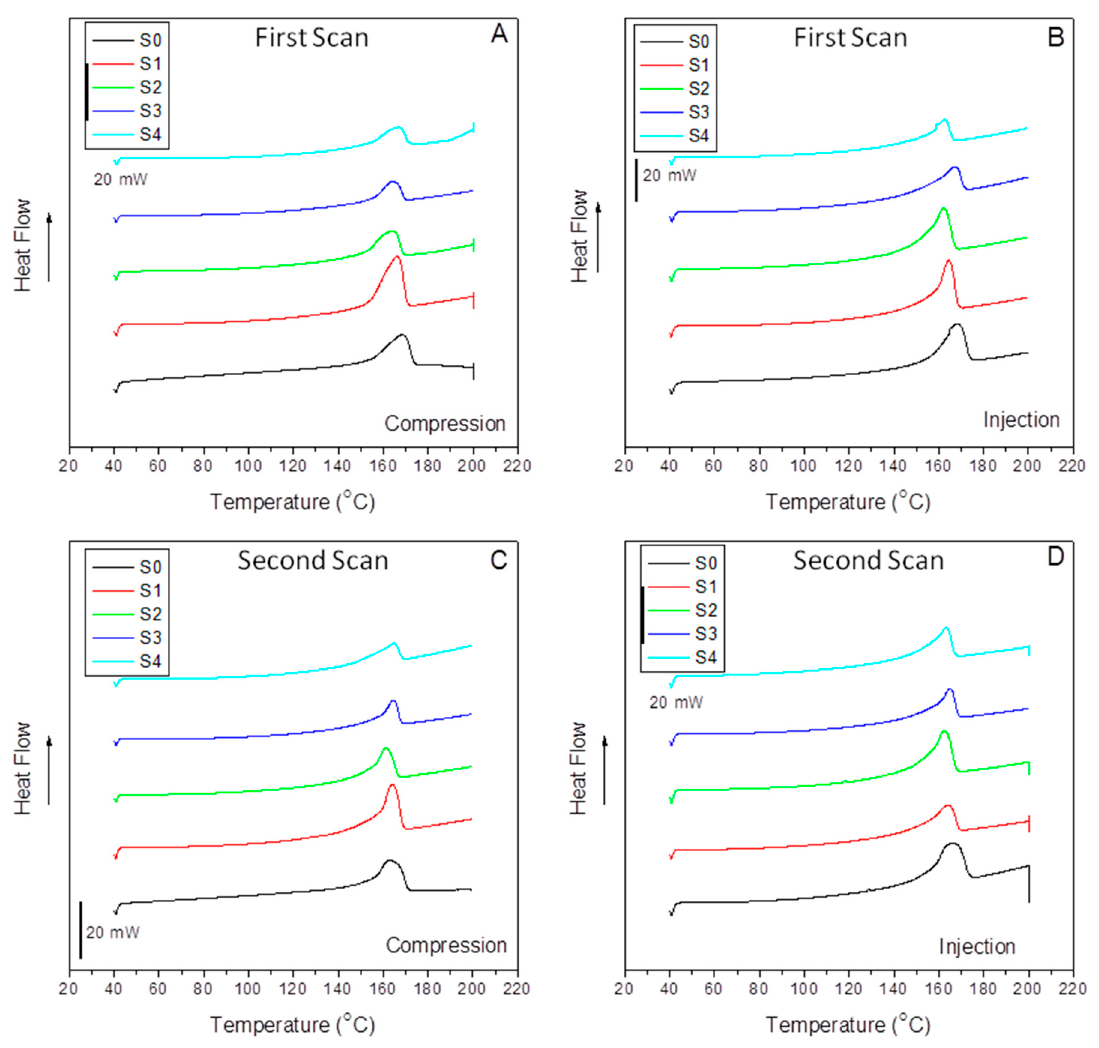
Figure 7. First and second DSC heating scans of the indicated samples under the compres- sion-molded ( A , C ) and injection-molded ( B , D ) thermal histories. ( A , C ) and injection-molded ( B , D ) thermal